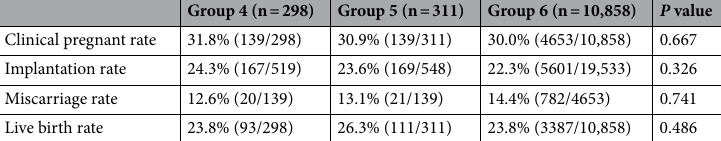
Table 4. Pregnant outcomes between three groups after FET.